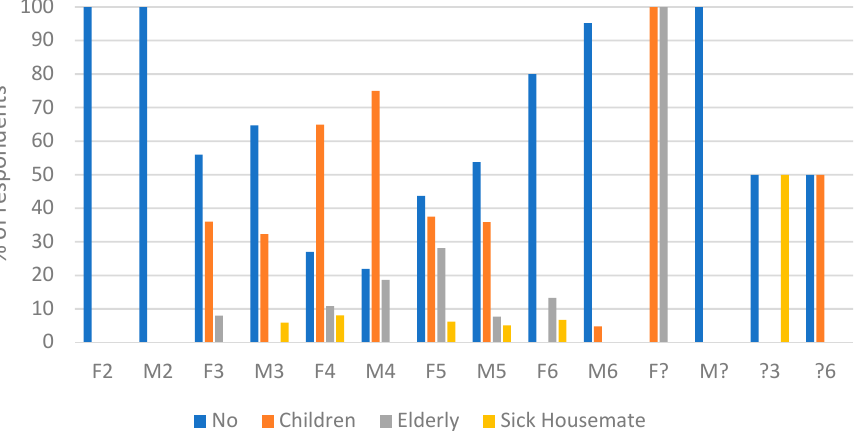
Figure 6. Percentage breakdown of responses to the question: “Did you have caring responsibilities (e.g., young children, elderly relatives, sick housemates)?” by gender and age, where F2 represents a female respondent aged 20–29, M3 represents a male respondent aged 30–39, and ? represents “prefer not to say” ( n = 257).